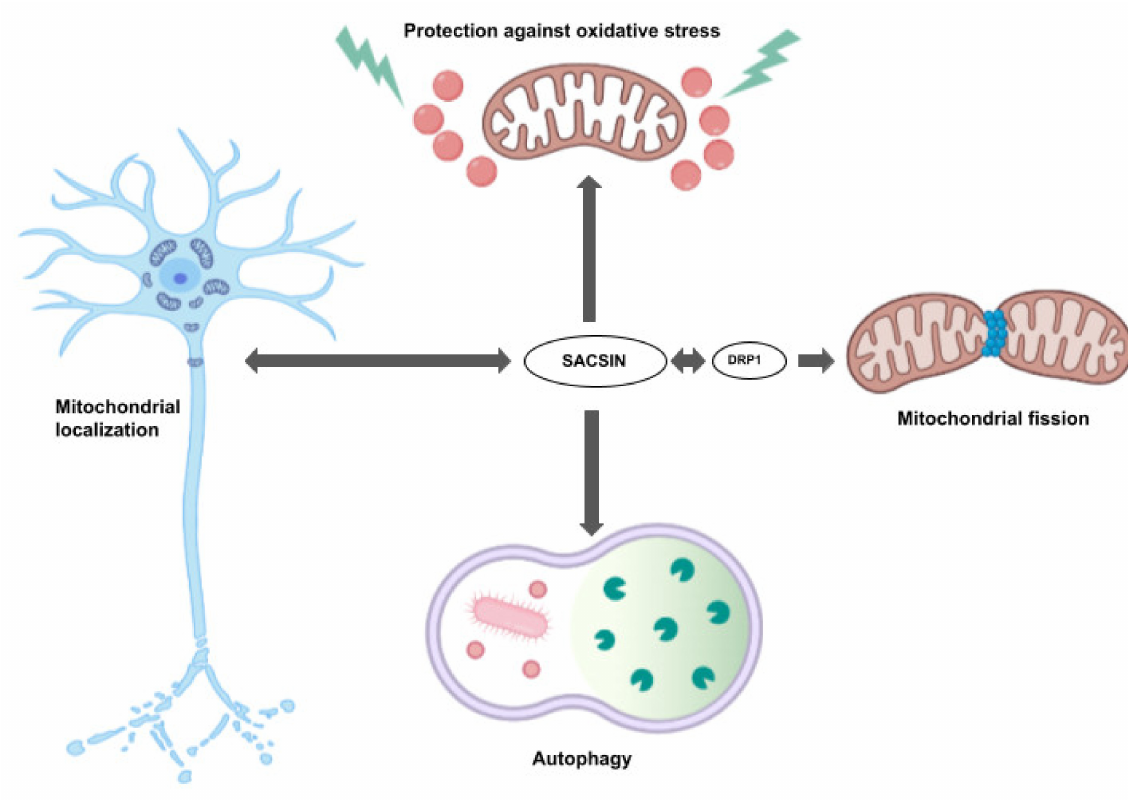
Figure 3. Sacsin involvement in mitochondrial